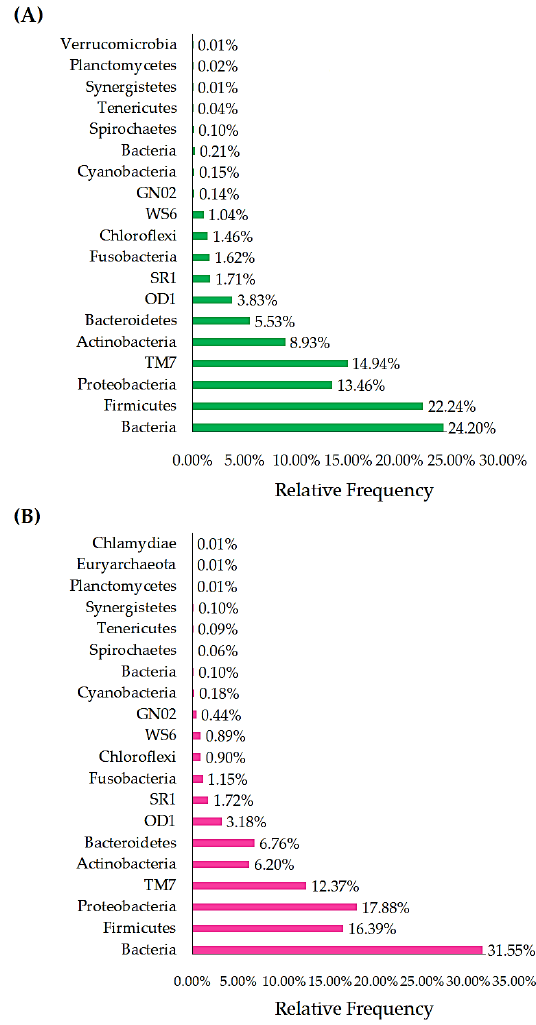
Figure 3. Comparison of the phylum-level relative frequency of PrTS ( A ) and PoTS ( B ) of the mouth-spray-treated group (G2). PrTS: pretreatment samples; PoTS: post-treatment samples.